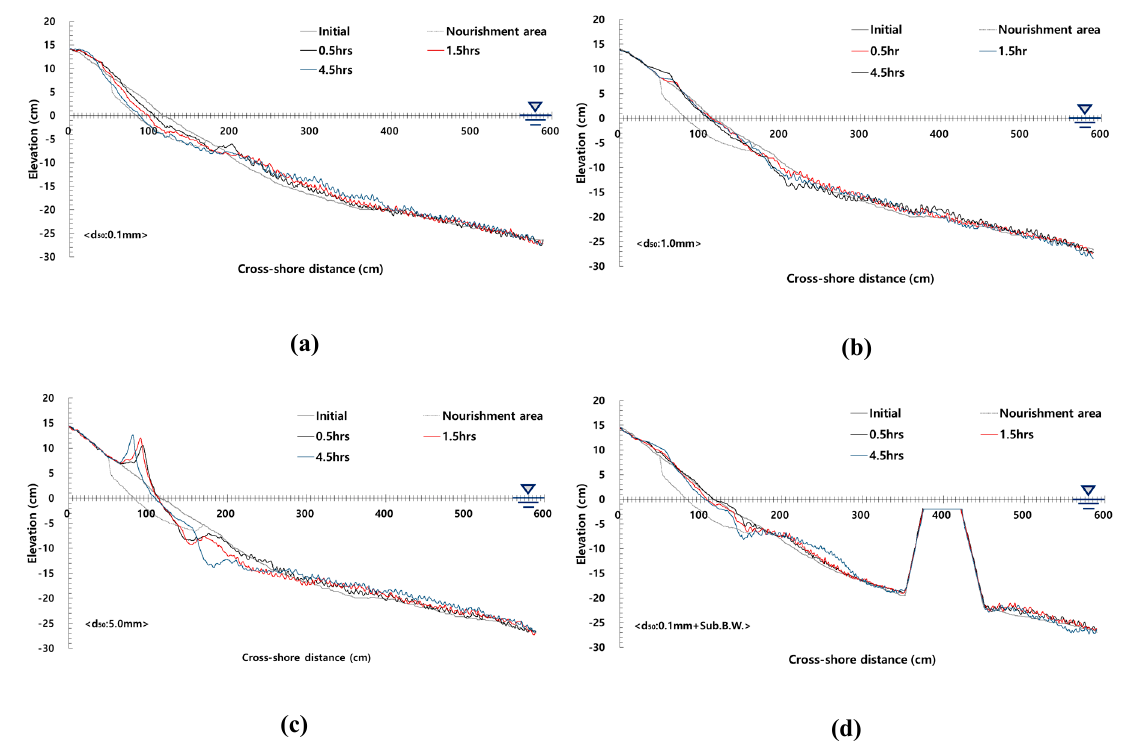
Figure 4. Beach profile evolution with wind velocity; U: 0 m/s : ( a ) d 50 , 0.1mm, ( b ) d 50 , 1 mm, ( c ) d 50 , 5mm, ( d ) d 50 , 0.1mm + Sub. B.W.